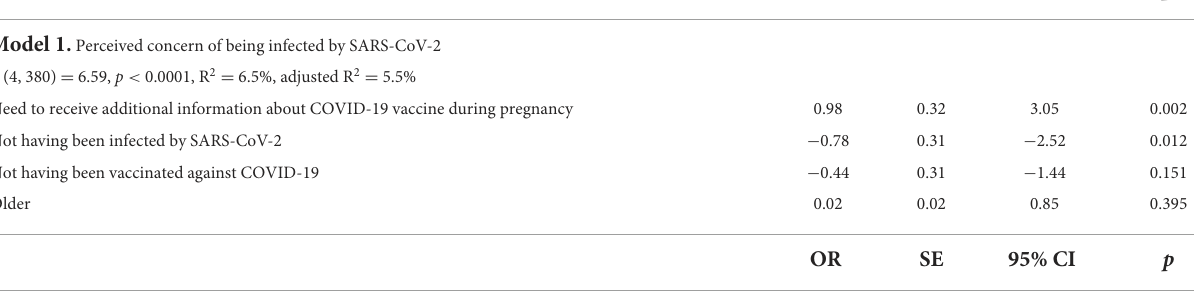
TABLE 2 Determinants of the different outcomes of interest using linear and logistic regression analysis. Variable Coeff. SE t